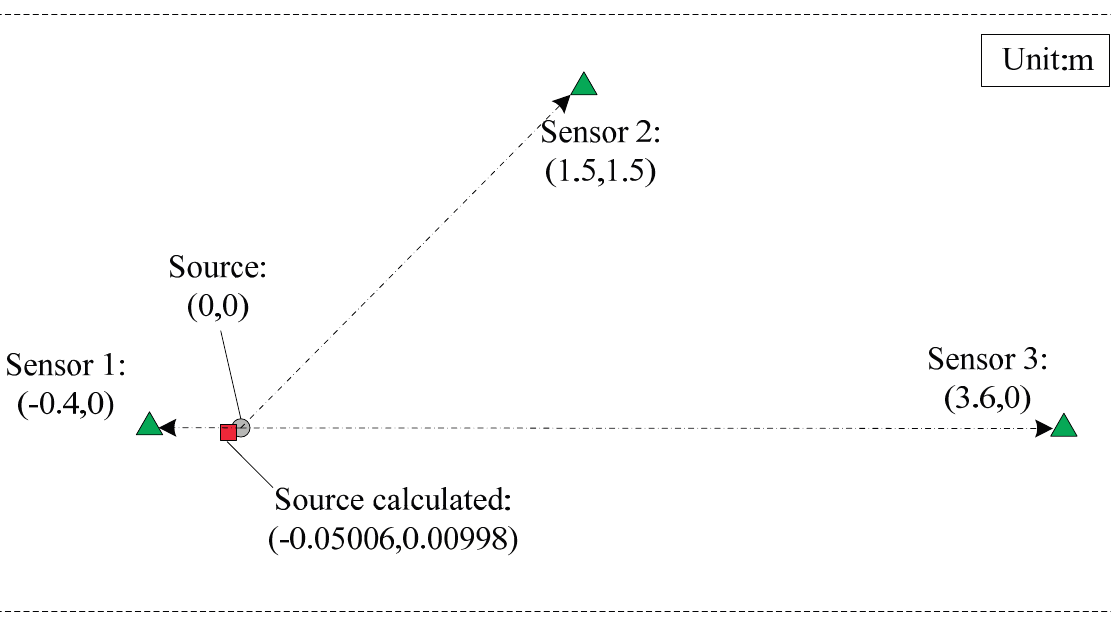
Figure 17. Schematic diagram of the positions of the source and the three sensors.